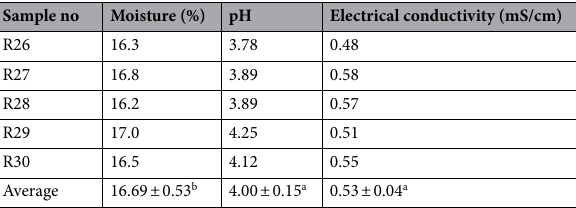
Table 2. Physicochemical properties of analyzed honey samples. Physicochemical properties of all analyzed honey samples [mean ± SD] from urban and rural apiaries. Mean values for each parameter and localization